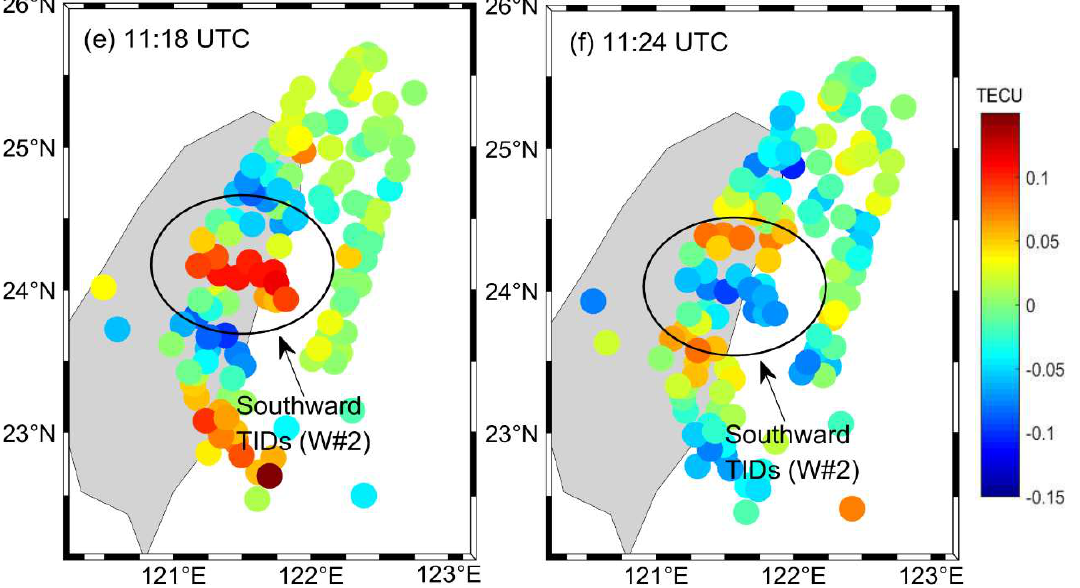
Figure 4. Change of the filtered TEC from 10:41 to 11:24 UTC. The W#1 and W#2 are shown in ( a – c ) Figure 4. The change of the filtered TEC at 10:41 UTC ( a ), 10:46 UTC ( b ), 10:51 UTC ( c ), 11:12 UTC and ( d – f ), respectively. The cross marker indicates the typhoon eye, the color bar represents the ( d ), 11:18 UTC ( e ) and 11:24 UTC ( f ). The W#1 and W#2 are shown in ( a – c ) and ( d – f ), respectively. amplitude of TEC changes, and the colored solid points show the position of SIP. The cross marker shows the typhoon eye, the color bar represents the amplitude of TEC changes, and the colored solid circle points show the position of